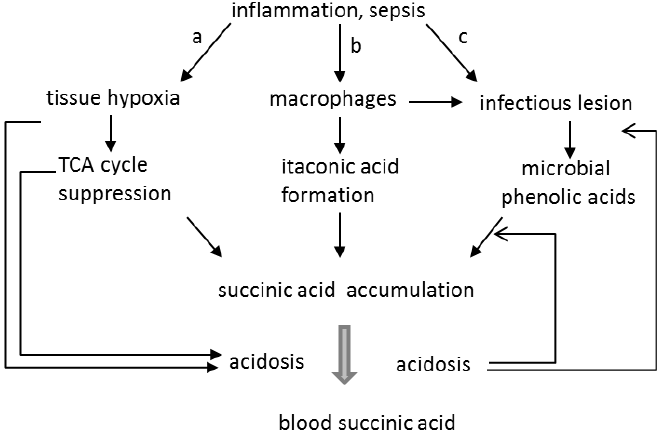
Figure 5. The combination of tissue and mitochondrial pathways contributing to an increase in the level of succinic acid in the blood of septic level of succinic acid in the blood of septic patients.